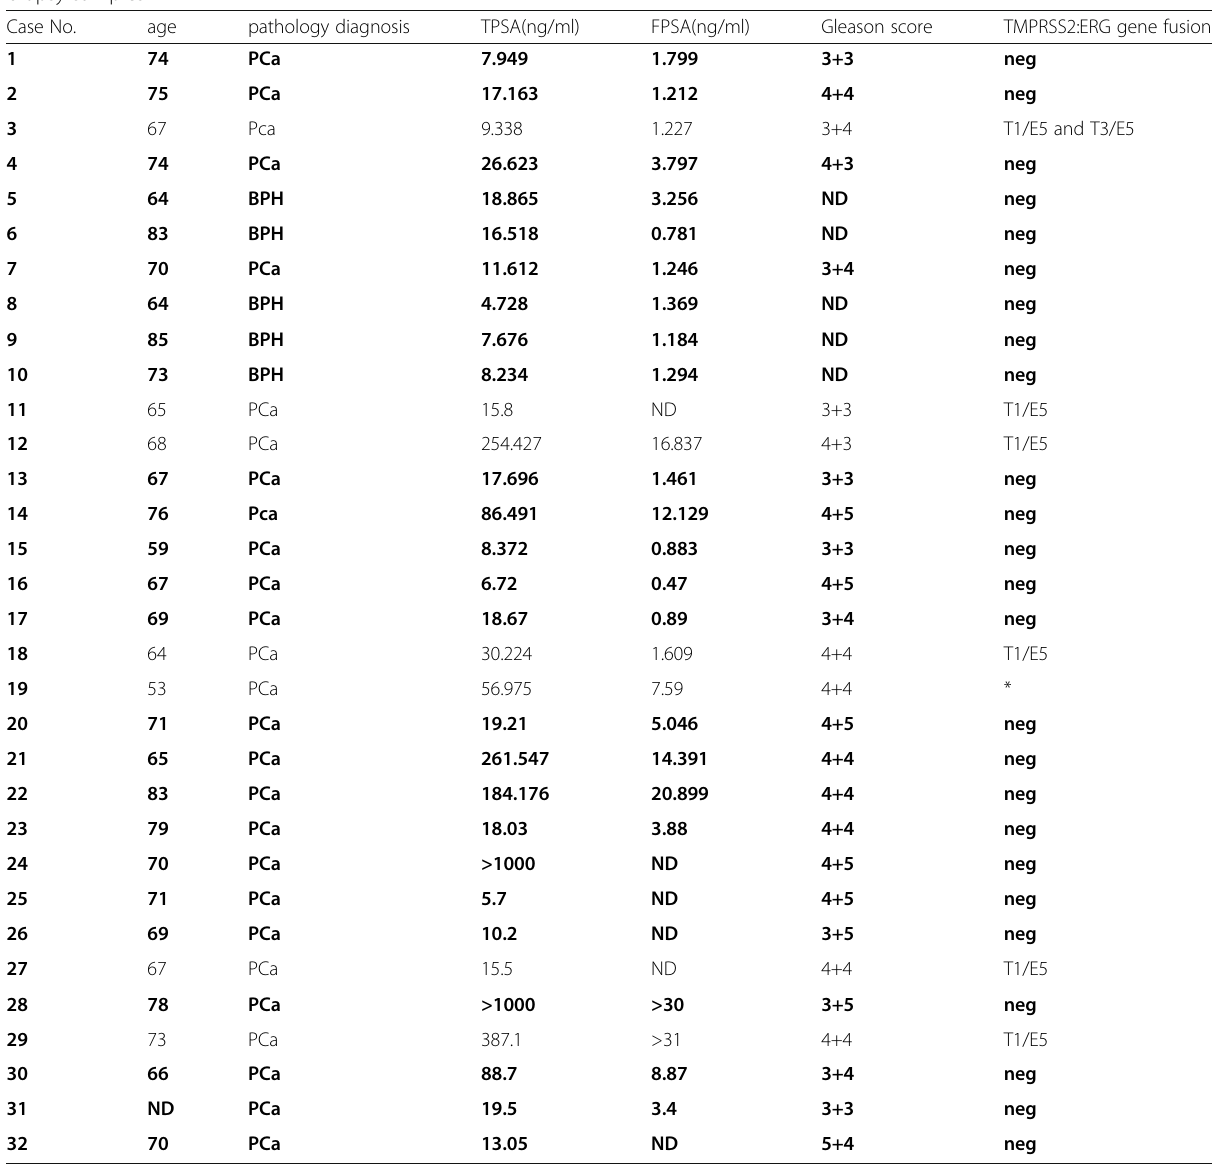
Table 1 Clinical data and TMPRSS2:ERG gene fusion status from the 27 cases of prostate cancer and 5 cases of BPH with needle biopsy samples Case